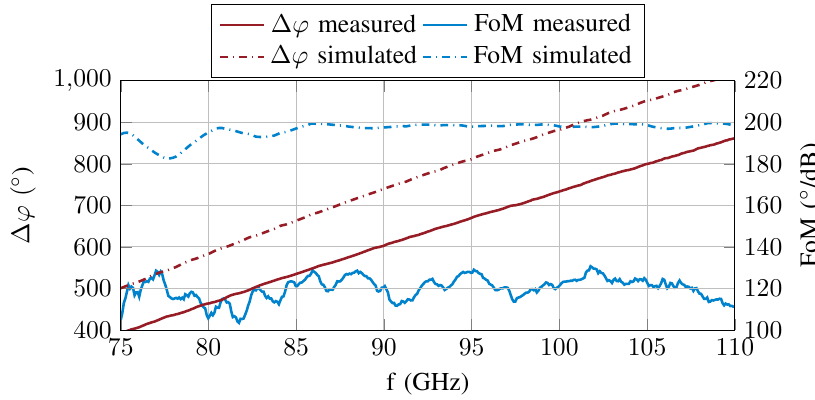
Figure 9. Measured and simulated FoM and differential phase shift of the sWL phase shifter.